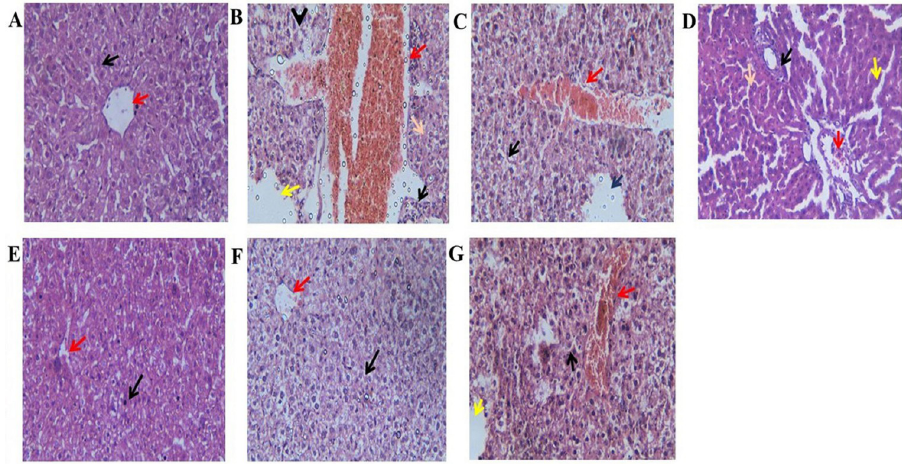
Fig 10. Histopathological examination of liver tissue sections in each group. ( A ) Control healthy showing normal hepatocytic cords with normal hepatic cells (Black arrows) and with clear central vein (Red arrows) (H&E, X400); ( B ) HCC-induced showing complete hepatocellular carcinoma, the hepatic tissue is necrotic and occupied by mononuclear cells infiltration (Black arrows) and pyknotic nucleus (orange arrows) and congested dilated portal tracts along with hemorrhage (Red arrows), and dilated sinusoids in between (yellow arrows) (H&E, X400); ( C ) HCC-Bee venom (1 mg/kg) showing focal area of hepatic necrosis occupied by pyknotic nucleus (Green arrows) and congested dilated portal tracts along with hemorrhage (Red arrows), and dilated sinusoids in between (Blue arrows), and all hepatocytes suffer from vacuolar and hydropic degeneration (Black arrows) (H&E, X400); ( D ) HCC-Bee venom (2 mg/kg) showing hepatic tissue is necrotic and occupied by mononuclear cells infiltration (Black arrows) and pyknotic nucleus (orange arrows) and congested dilated portal tracts along with hemorrhage (Red arrows), and dilated sinusoids in between (yellow arrows) (H&E, X400); ( E ) HCC-Targeted bee venom-CSNPs (0.5 mg/kg) showing clear central vein (Red arrows) and almost normal hepatocyte with some hepatocytes suffer from vacuolar and hydropic degeneration (Black arrows) (H&E, X400); ( F ) HCC-Targeted bee venom-CSNPs (1 mg/kg) showing central vein with some hemorrhage (Red arrows) and almost normal hepatocyte with some hepatocytes suffer from vacuolar and hydropic degeneration (Black arrows) (H&E, X400); ( G ) HCC-Non-targeted CSNPs (2 mg/kg) showing focal area of hepatic necrosis occupied by pyknotic nucleus (Black arrows) and larger degenerated area occupied by centrilobular congestion and congested dilated portal tracts along with hemorrhage (Red arrows), and dilated sinusoids in between (yellow